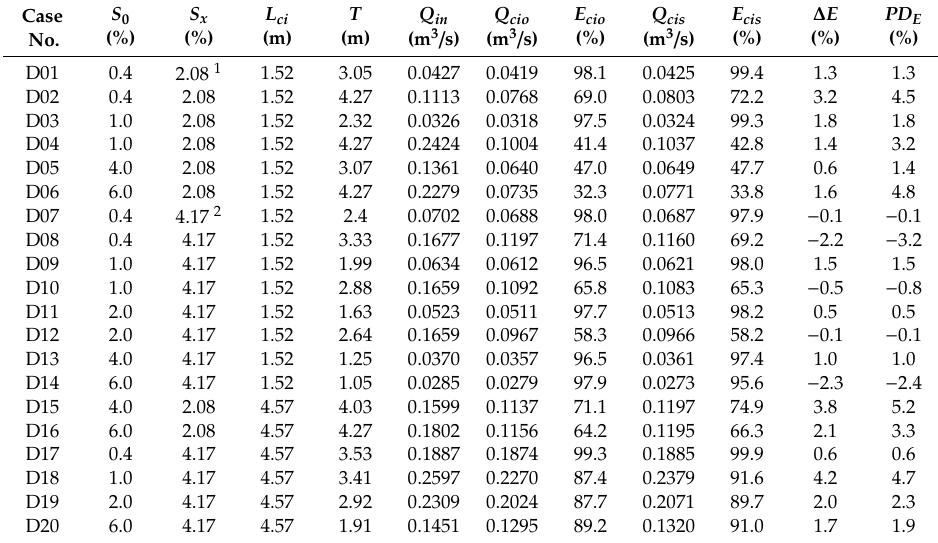
Table 2. Geometry and inflow parameters and simulation results of 20 Type D locally depressed curb inlet modeling